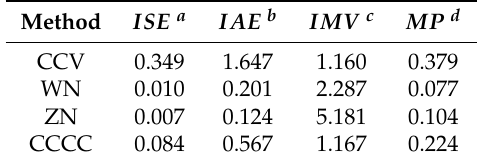
Table A12. Performance indexes. Disturbance rejection for the set P 6 .